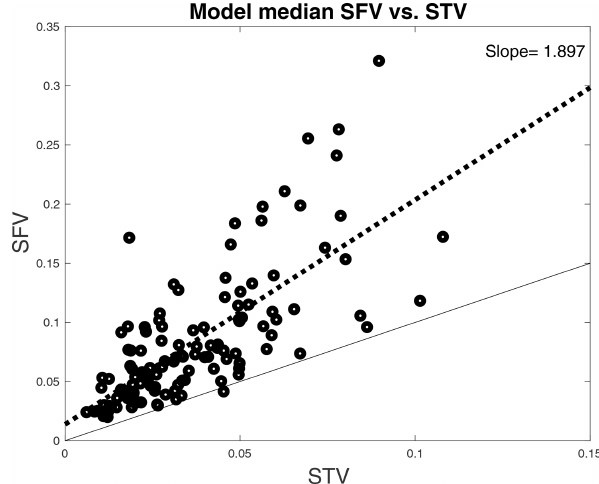
Figure 11. An example of how STV relates to precipitation at one mooring location. Maximum hourly precipitation for each short- term ensemble for the mooring (at 0 ◦ N, 10 ◦ W) vs. STV for the same set of ensembles. The light line indicates a rain rate of 1mmhr − 1 , separating rainy periods from non-rainy ones. Median values for all ensembles with a maximum precipitation of less than 1mmhr − 1 (below the line) and greater than or equal to 1mmhr − 1 (above the line) are shown in the bottom right. These values indicate that STV tends to be greater when there is rainfall. However, there is not a clear correlation between rainfall and STV. This pattern was consistent in most of the GTMBA moorings with precipitation records.